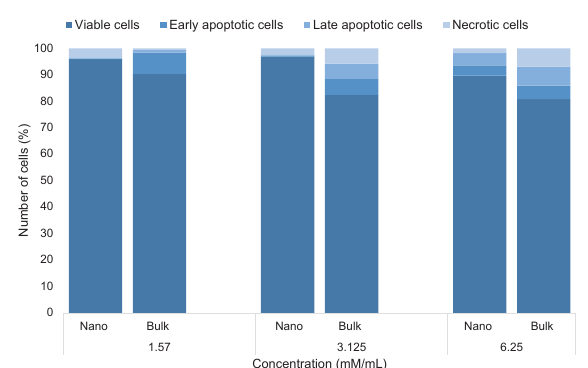
Figure 4. The percentage of HT-29 in terms of living, early apoptotic, late apoptotic, and necrotic cells